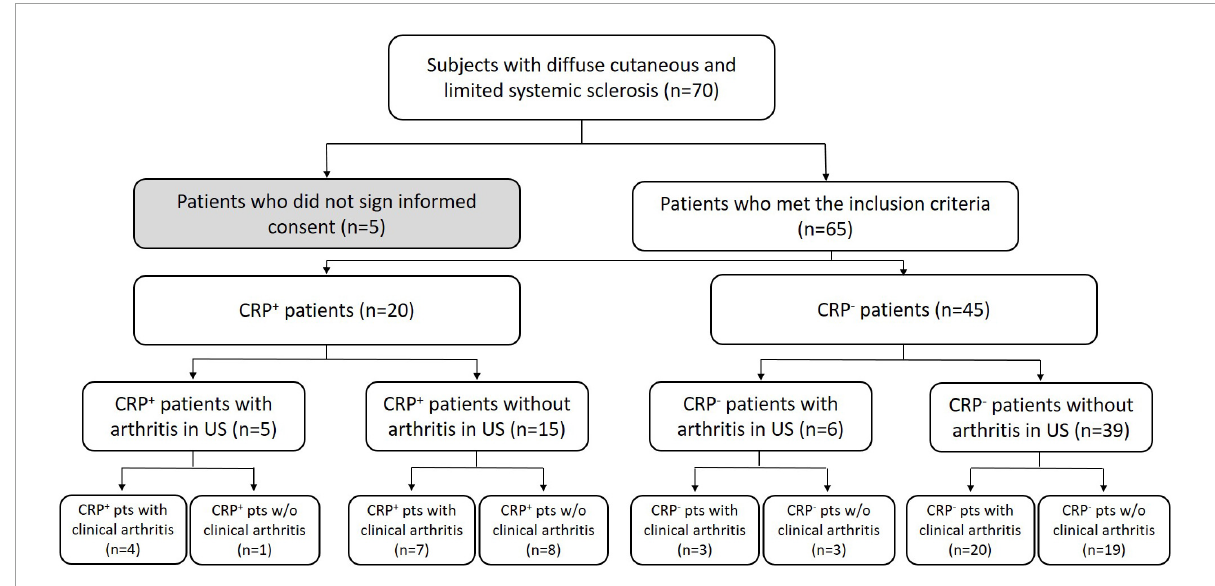
FIGURE1 STROBE-diagram of group allocation as well as inclusion and exclusion criteria are